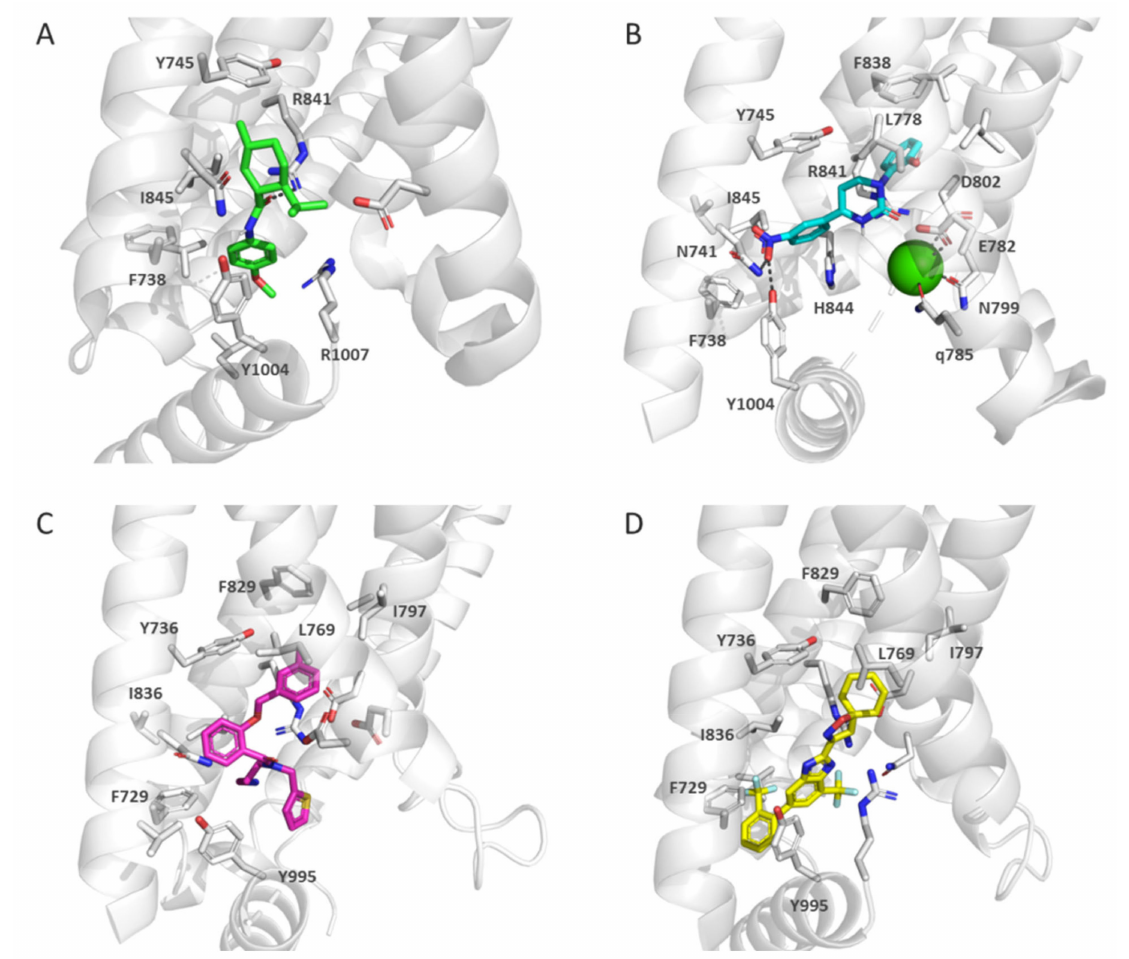
Figure 3. Representation of TRPM8 ligands within the receptor binding site (grey). ( A ) fa TRPM8-WS-12 (green) (pdb code 6NR2), ( B ) fa TRPM8-Icilin (cyan) (pdb code 6NR3), ( C ) pm TRPM8-AMTB (pink) (pdb code 6O6R), ( D ) pm TRPM8 TC-I 2014 (yellow) (pdb code 6O72). Residues discussed in the test are labeled. Ca 2+ is depicted as a green sphere, and hydrogen bonds as dashed grey lines. For clarity, only polar hydrogens are shown. Software for creating images